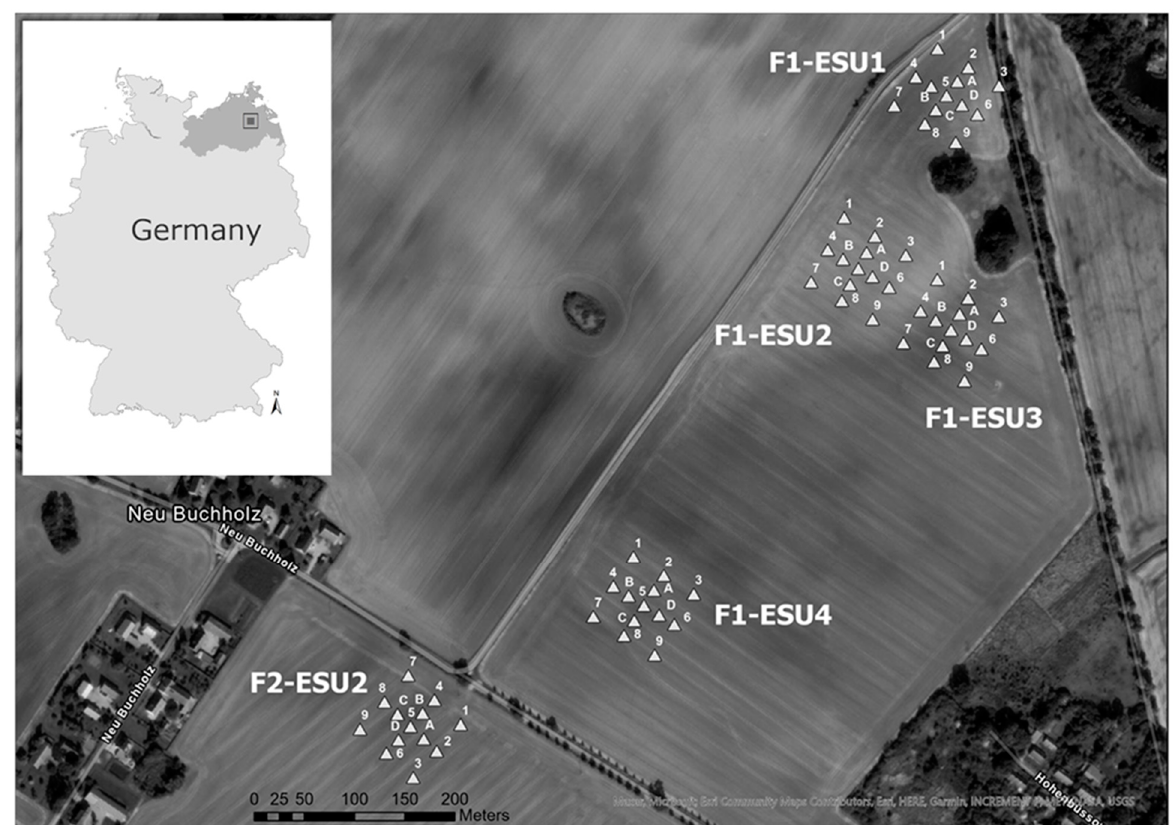
Figure 1. Study area and Elementary Sampling Unit Design (ESU) of the winter wheat sampling campaign in 2021. The campaign was conducted on two fields (F1, F2). A ESU comprises of 13 Secondary Sampling Units (SSU). Nine of these are arranged in three rows of three sampling locations each and numbered from one to nine. Additionally, there is a quadrant of sampling locations around the center (SSU 5) labeled A through D. All sampling locations are aligned according to the management direction to minimize conflicts with regular management activities.